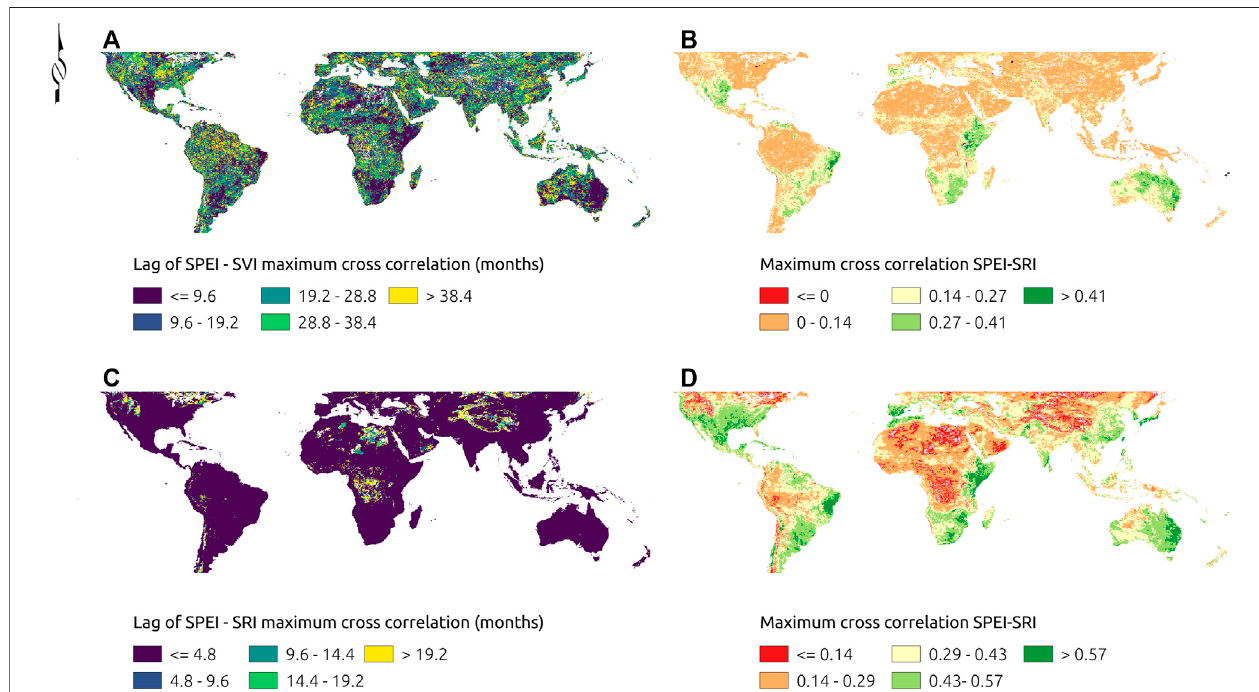
FIGURE 7 | SPEI-SVI (A,B) , and SPEI-SRI (A,C) response lag (A,C) corresponding to the maximum cross correlation (B,D) between variables. White pixels correspond to locations where the maximum cross correlations were non-signi fi cant.